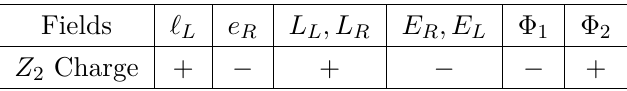
Table 1 . Table contains the Z 2 charges of leptons and scalars present in the